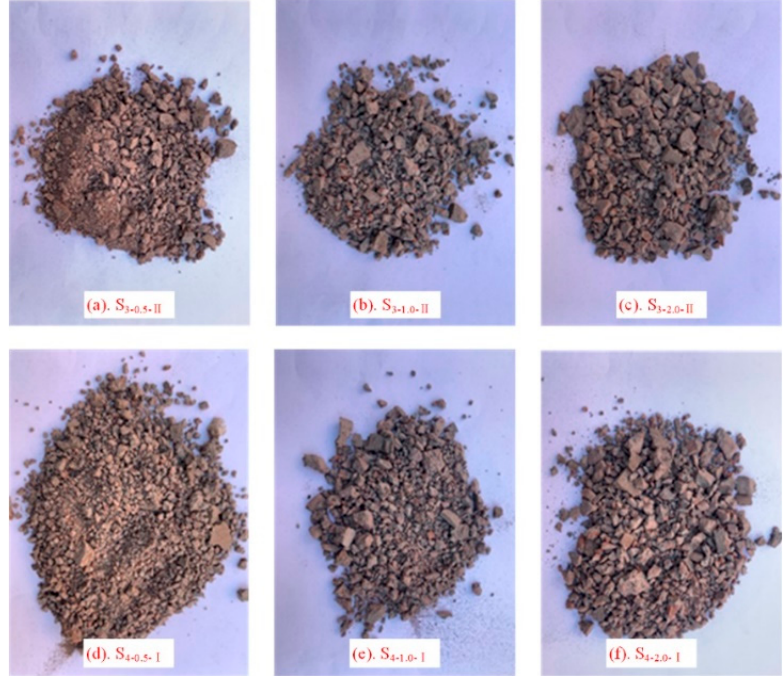
Figure 8. Failure and fractal nature of impact fragments of cemented rock samples for different PSDs. Original samples had Talbot indices 0.5, 1.0, and 2.0. 3-component samples.